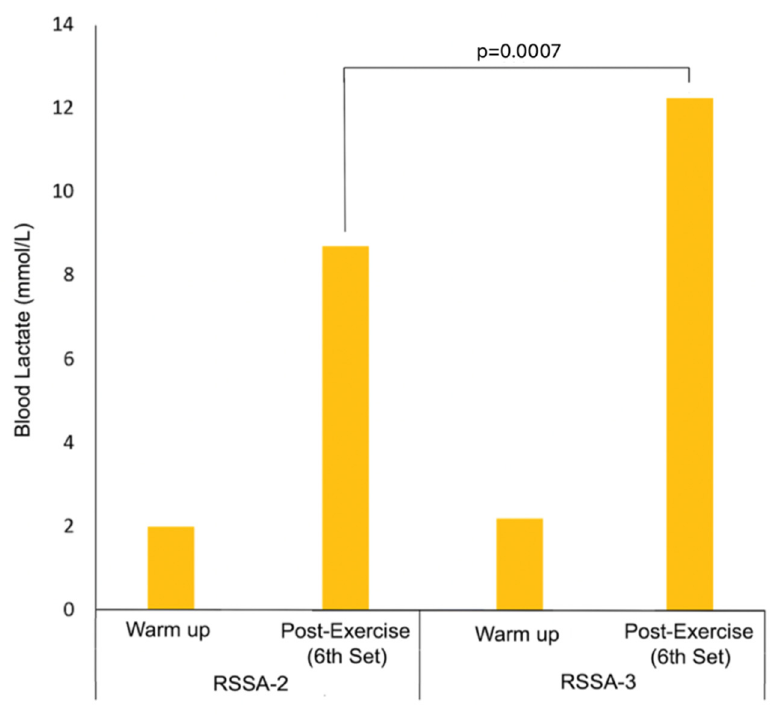
Figure 6. Blood lactate concentration after warmup and following the last set of RSSA-2 and RSSA-3 tests.